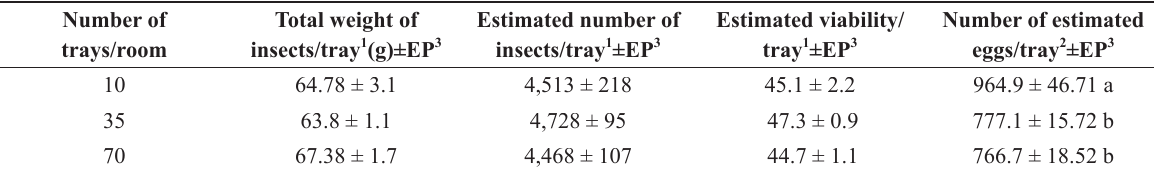
Average of total weight of insects, estimated average of the number of insects, viability of the egg-to-adult period and number of eggs produced per tray, originated from A. kuehniella emerged in rearing trays kept in rooms with different